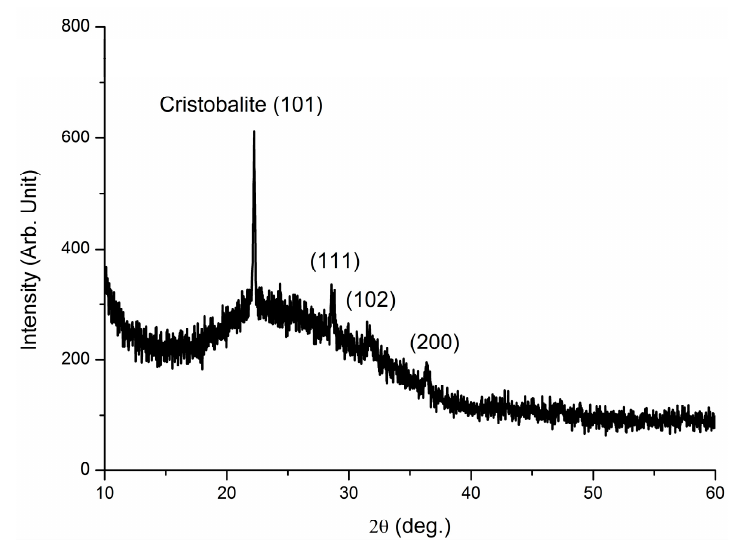
Figure 6. X-ray diffraction patterns of the crystallized optical fiber after two annealing treatments.